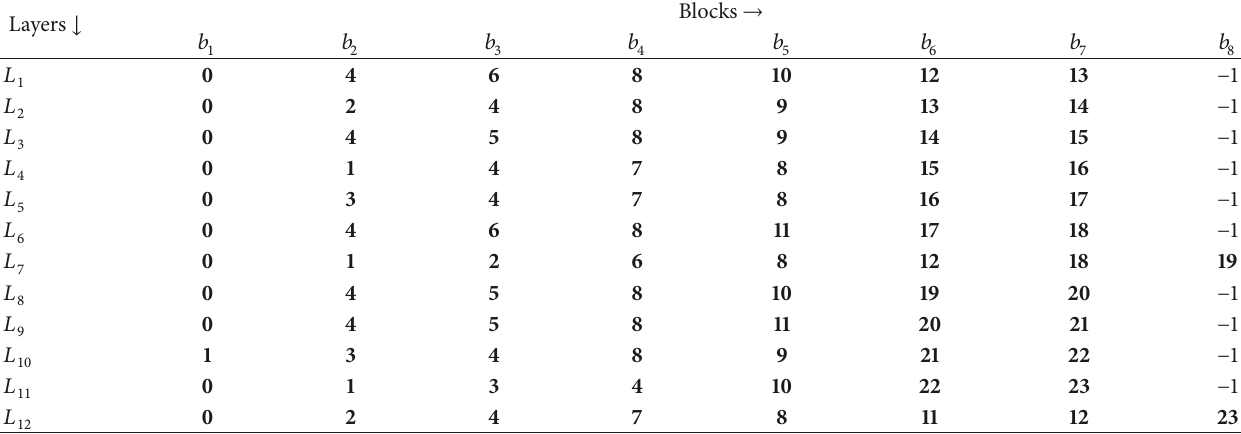
Table 4: Block index matrix 𝛽 I showing the valid blocks (bold) to be processed.